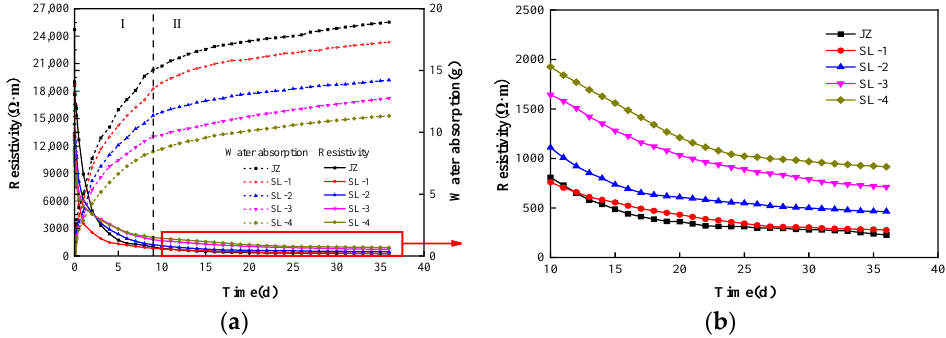
Figure 6. Changes in water absorption and resistivity of cement mortar with different SL contents over time:( a ) Macroscopic damage; ( b ) Partially enlarged drawing.